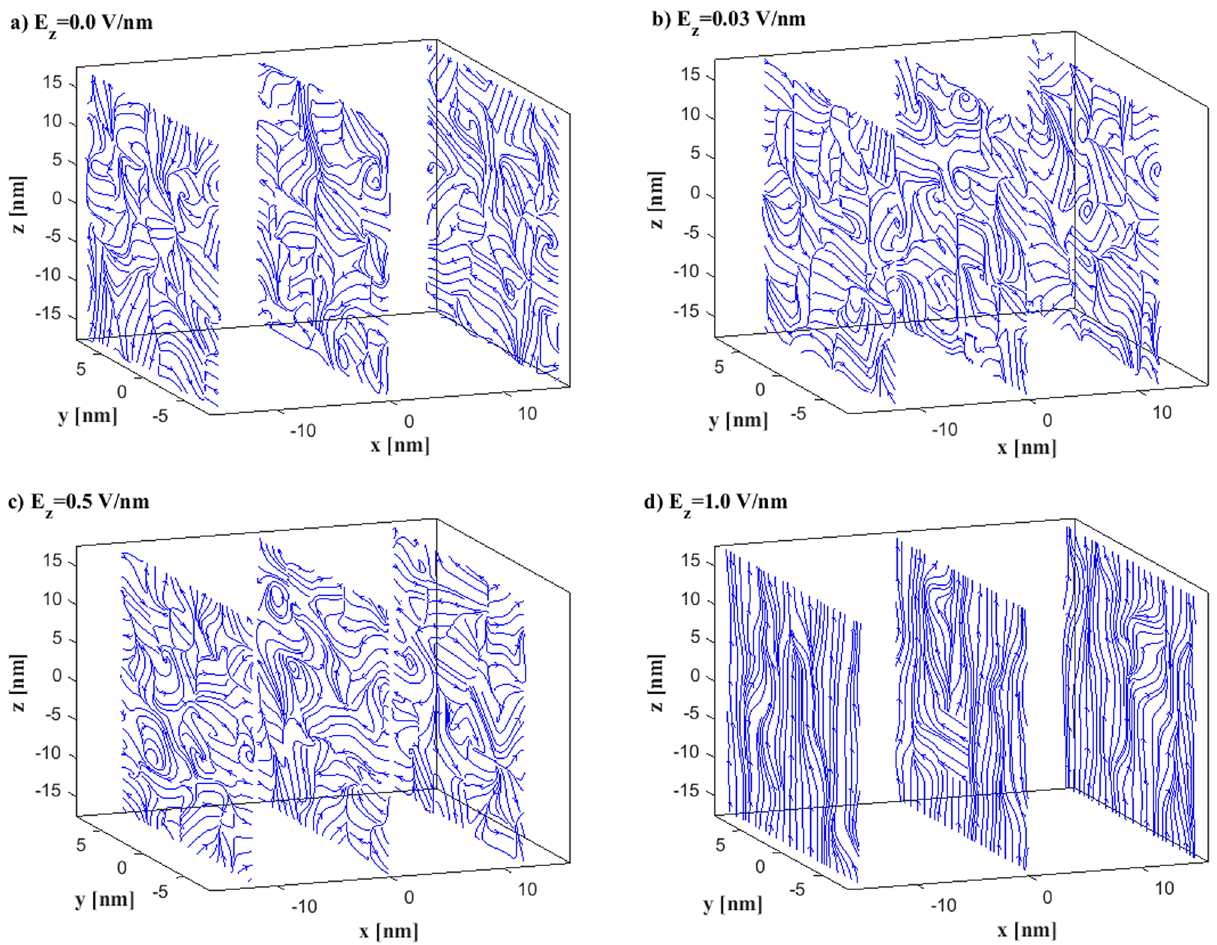
Figure 3. Electric field lines inside the h = 3 nm, ε wf /ε ff = 0.1 ( a ) E z = 0.0 V/nm, ( b ) E z = 0.03 V/nm, ( c ) E z = 0.5 V/nm, ( d ) E z = 1.0 V/nm. Three different yz -planes along the x -direction are shown for each case. Water/ ions not shown for presentation